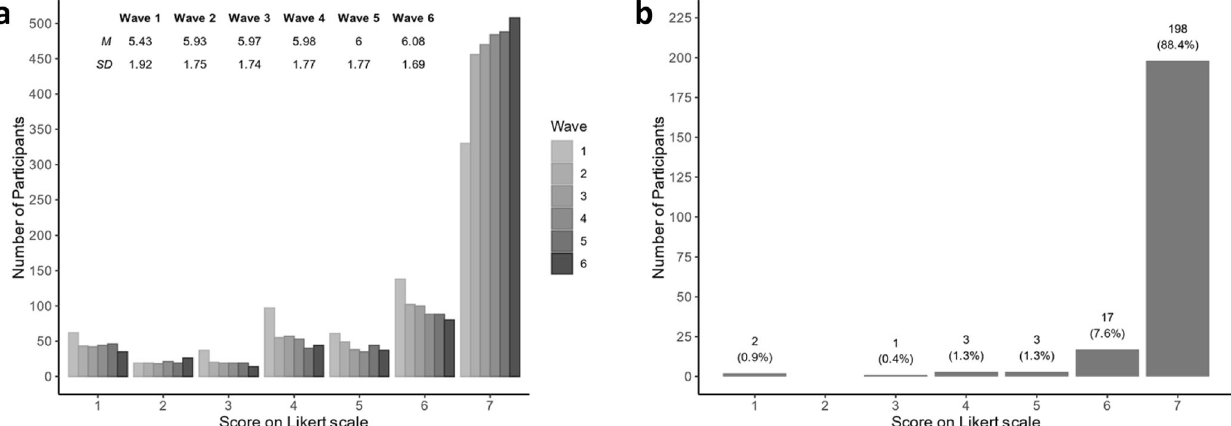
Fig. 3 Descriptive results of COVID-19 vaccination intention. a Distribution of respondents ’ scores on COVID-19 vaccination intention for each wave. Table with mean (M) and standard deviation (SD) per wave for COVID-19 vaccination intention score inserted above. b Last known score on COVID-19 vaccination intention (displayed on X axis) of participants who reported to have been vaccinated against COVID-19 ( n = 224).